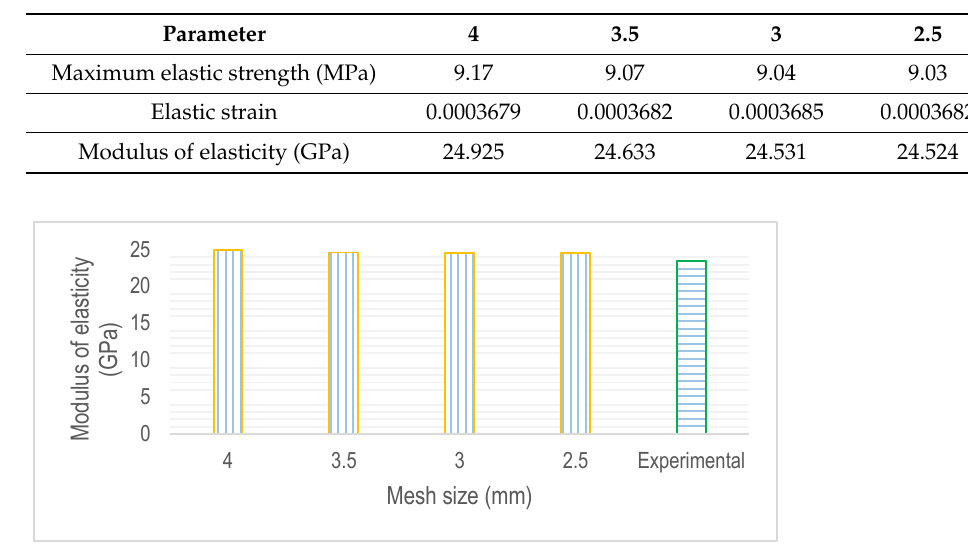
Figure 7. Modeling results vs. experimental value. Modulus of elasticity.